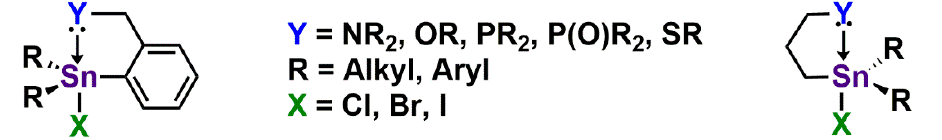
Figure 1. Hypercoordinated triorganotin compounds containing benzyl- (left) and propyl- (right) functionalized ligands.